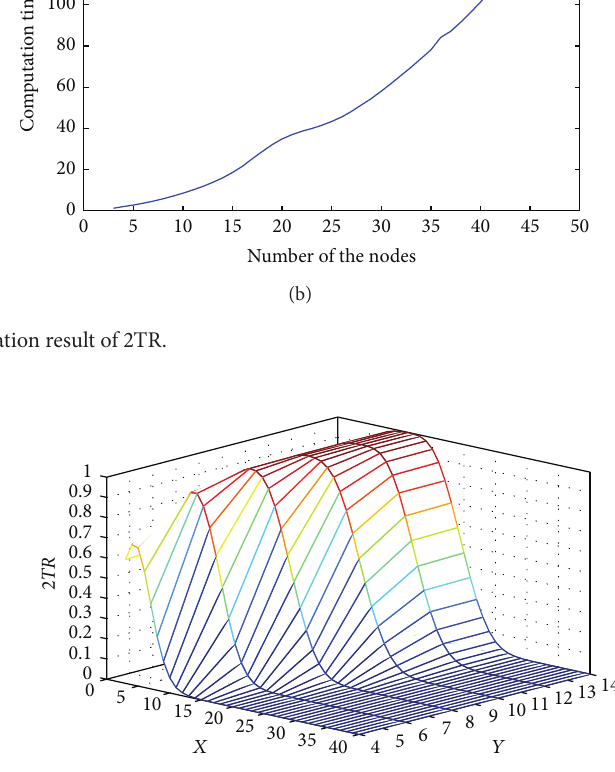
Figure 7: Sensibility of parameter 𝛽